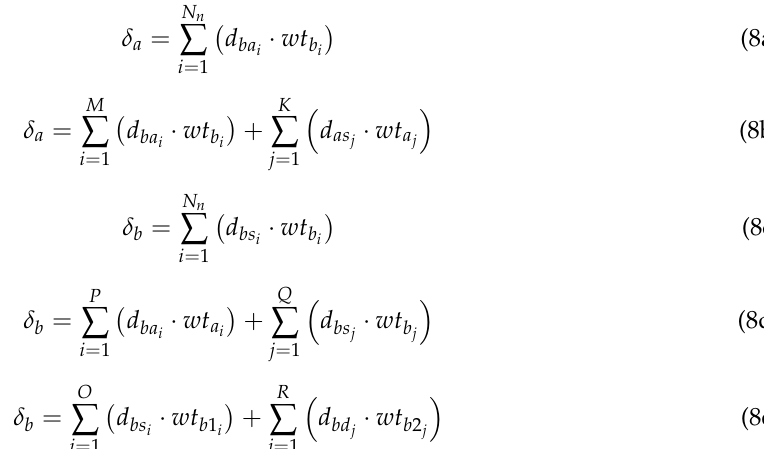
Figure 3. Different situations of under test pixels and the neighboring pixels In Figure 3 , “ ◦ ” denotes background class A, “ • ” denotes background class B, and “ (cid:70) ” denotes anomalous pixels. The distance for the situations presented in Figure 3a–e can be, respectively, defined using Equation